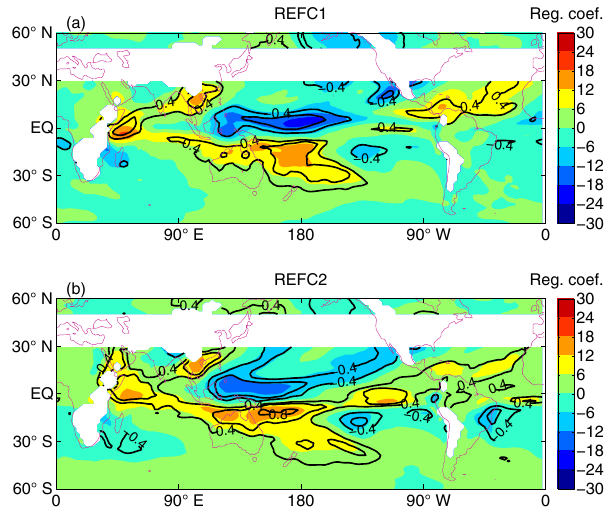
Figure 12. As in Fig. 9a and b but for JJA.